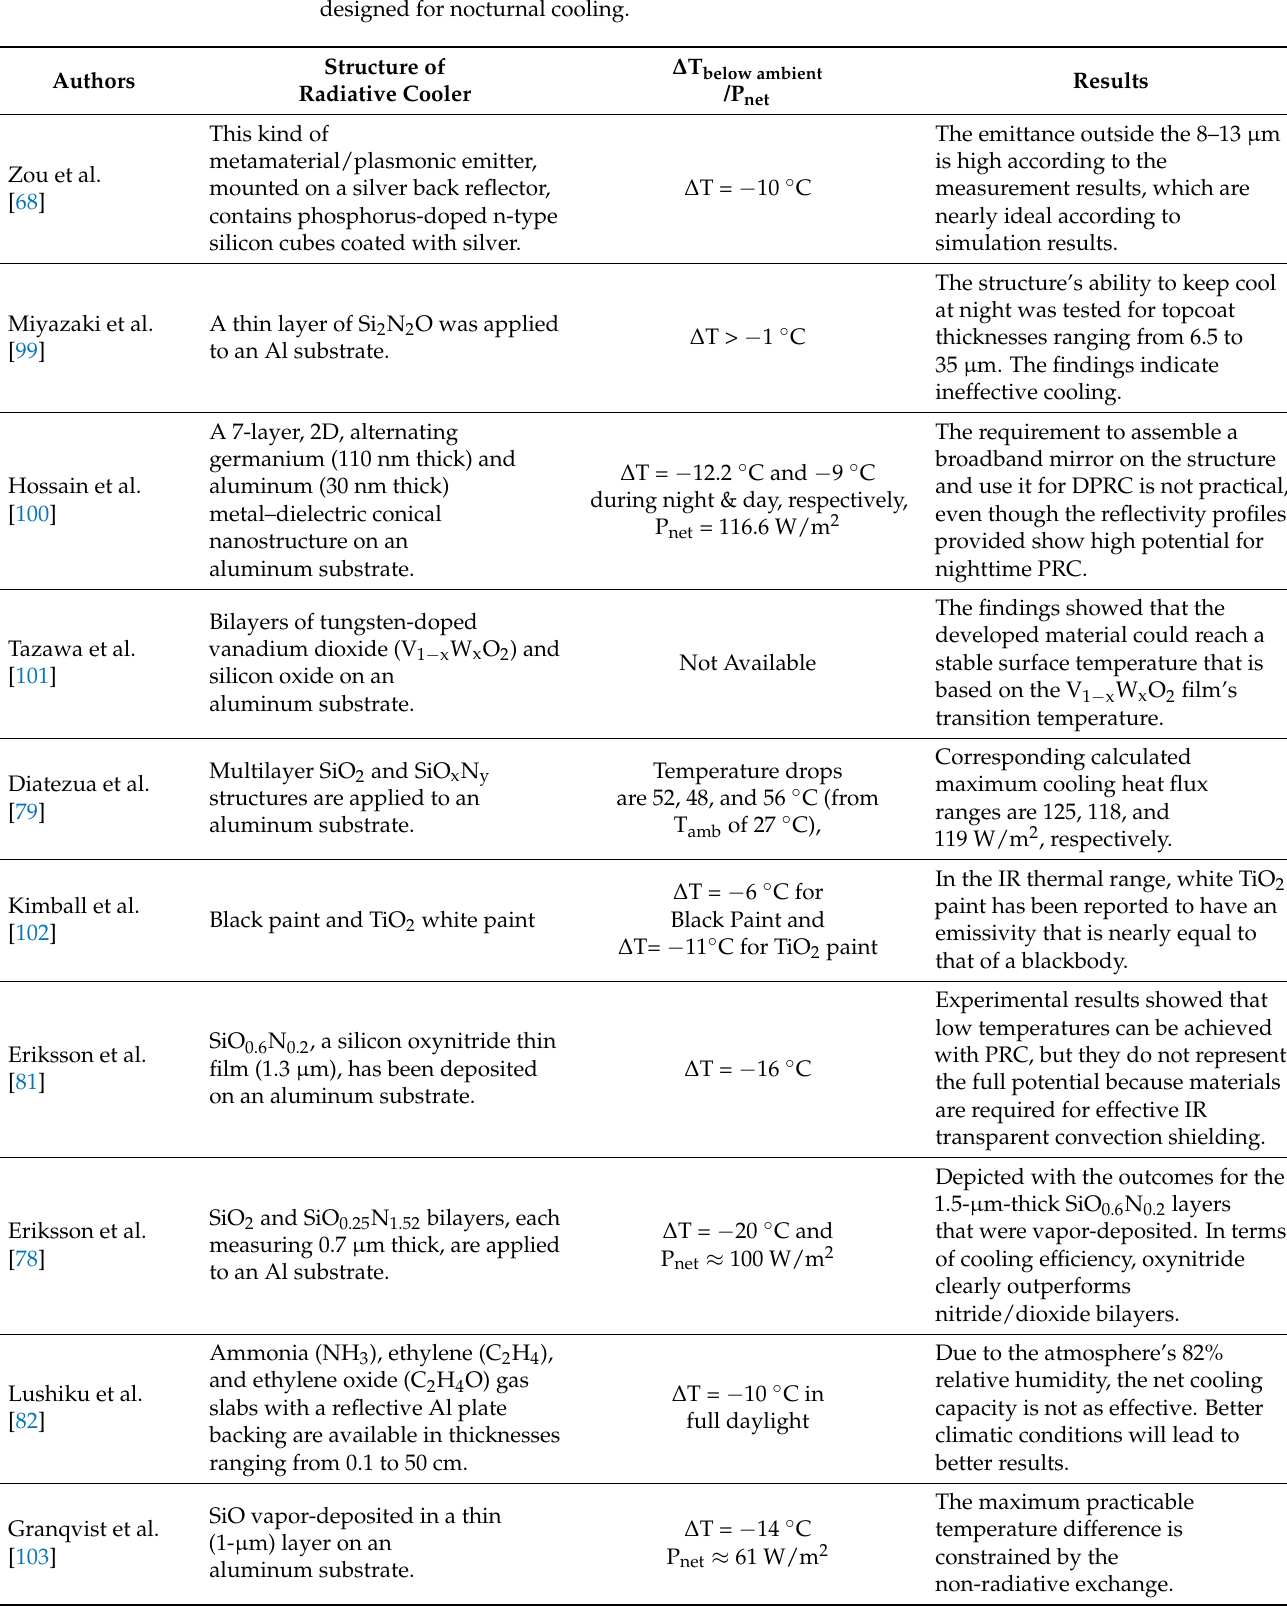
Table 1. An overview of the material composition, structures, and characteristics of a radiator designed for nocturnal